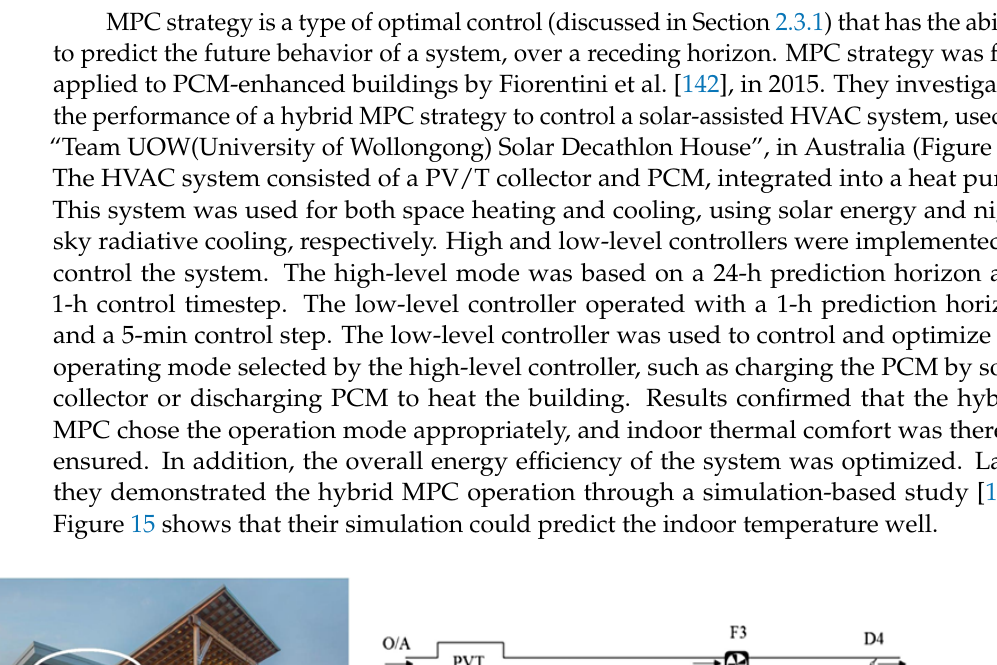
Figure 13. Basic structure of Model predictive control (MPC) strategy [141].